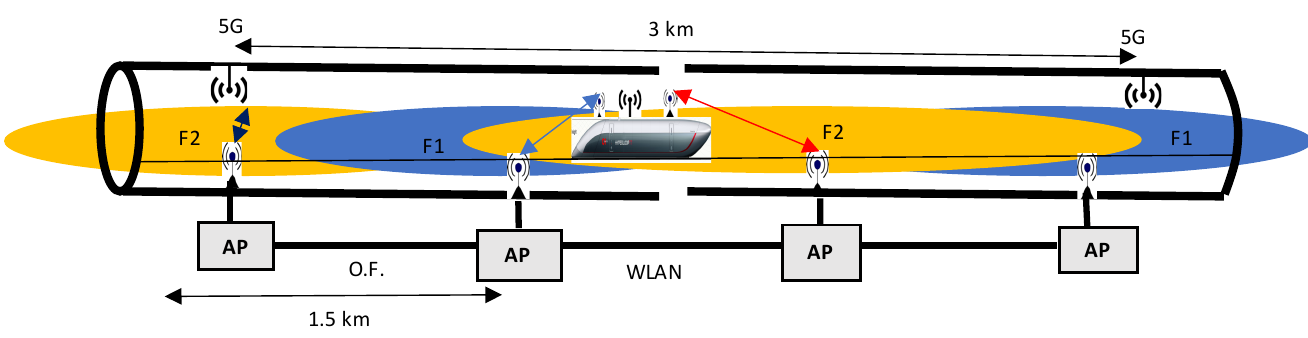
Figure 6. Proposal of design of a redundant network with strong overlap for critical communications and 5G for